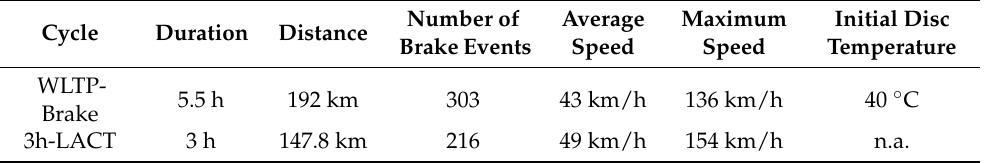
Table 1. Important parameters of the WLTP-Brake and the 3h-LACT